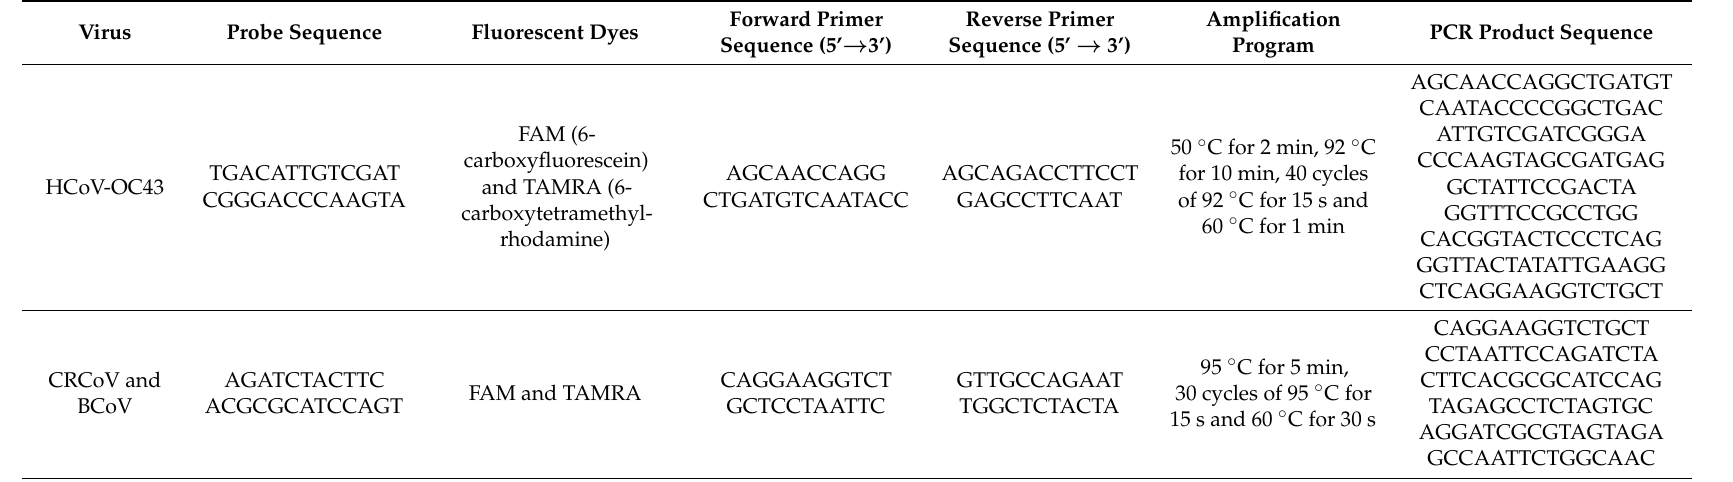
Table 1. Probes and primers used in polymerase chain reaction (PCR)